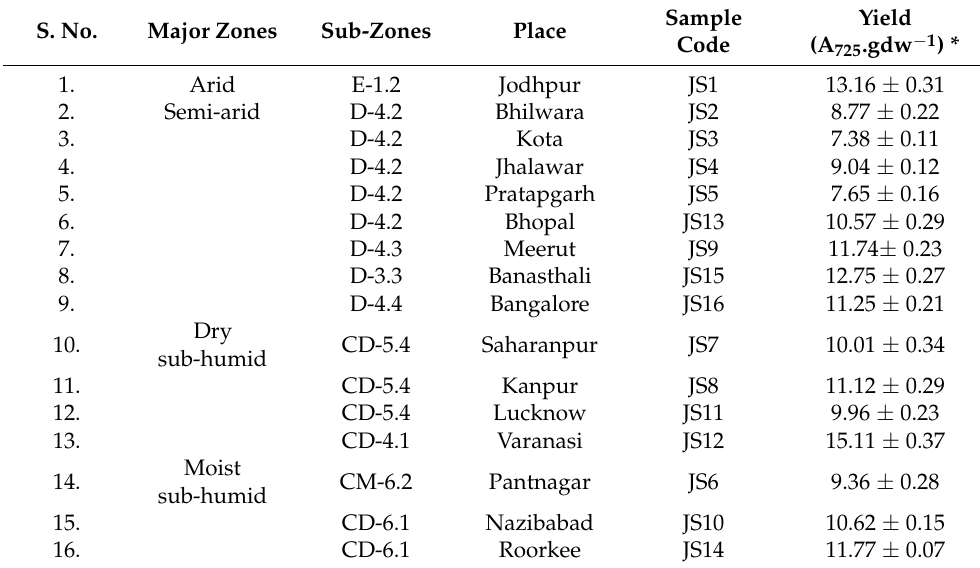
* The values represent the mean ± SD with n = 3.